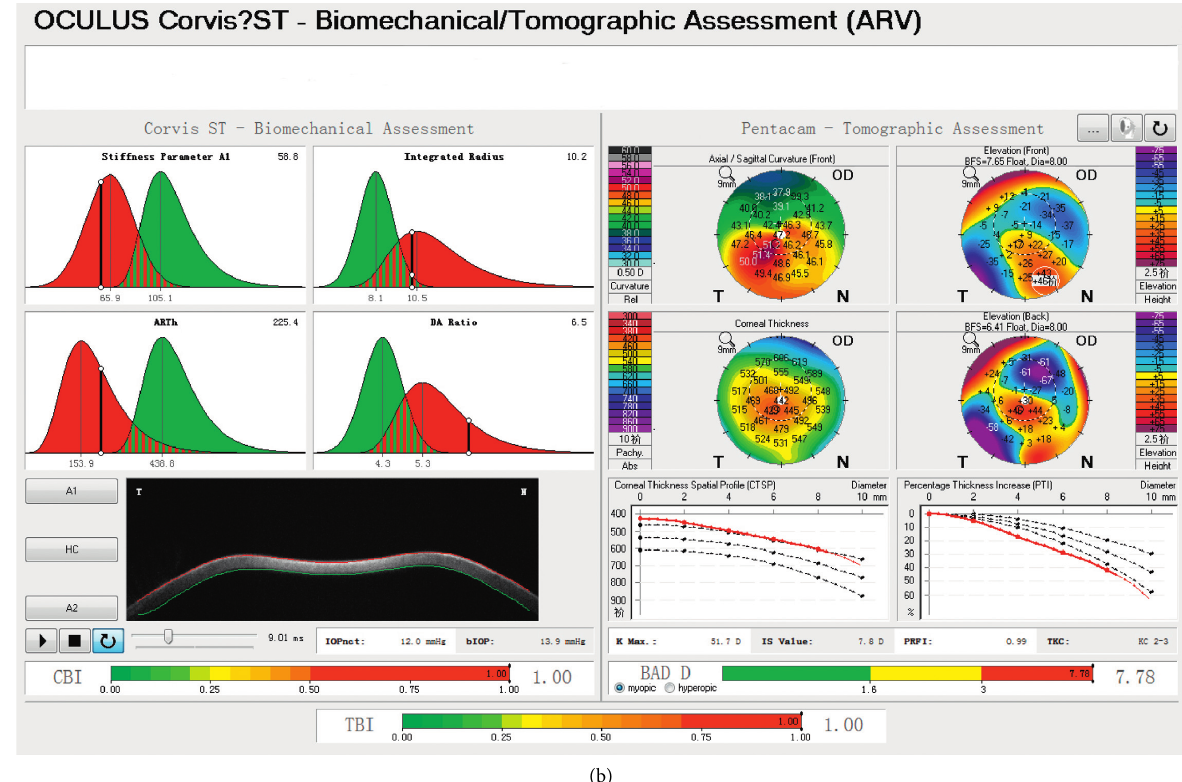
Figure 2: Biomechanical/topographic assessments (ARV) showing Corvis Biomechanical Index (CBI), Belin/Ambr´osio Enhanced Ectasia Deviation Index (BAD-D), and Tomographic and Biomechanical Index (TBI) for the post-LASIK ectasia (a) and primary keratoconus (b) with matching age and central corneal thickness.